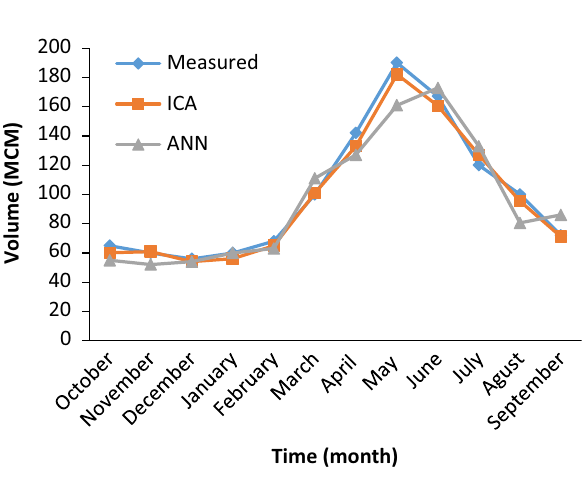
Fig. 11 Comparison of the measured and predicted reservoir storage values by ICA and